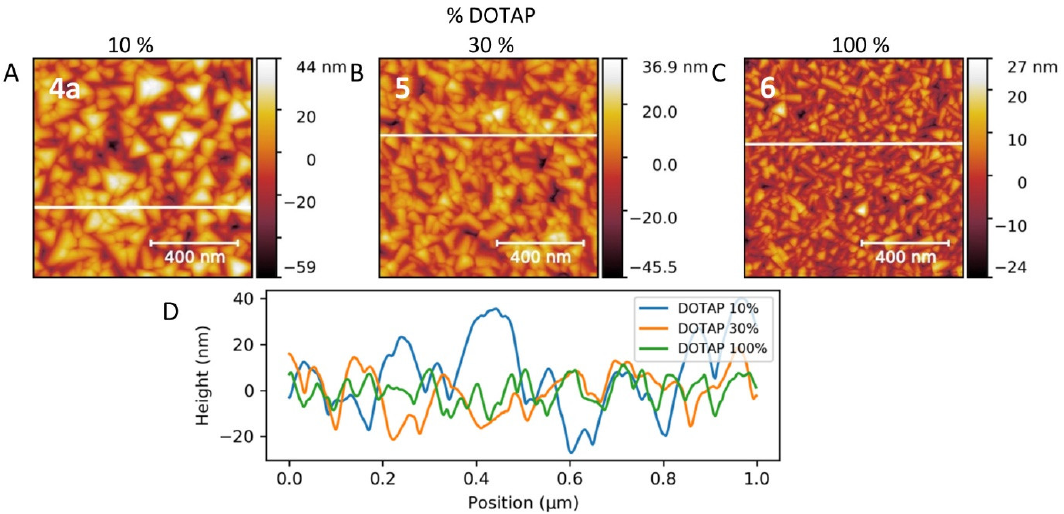
Figure 8. AFM images of samples 4a ( A ), 5 ( B ), and 6 ( C ) corresponding to the growth on POPC:DOTAP SLB for 10%, 30%, and 100% of DOTAP, respectively; ( D ) Height profiles for the three samples.